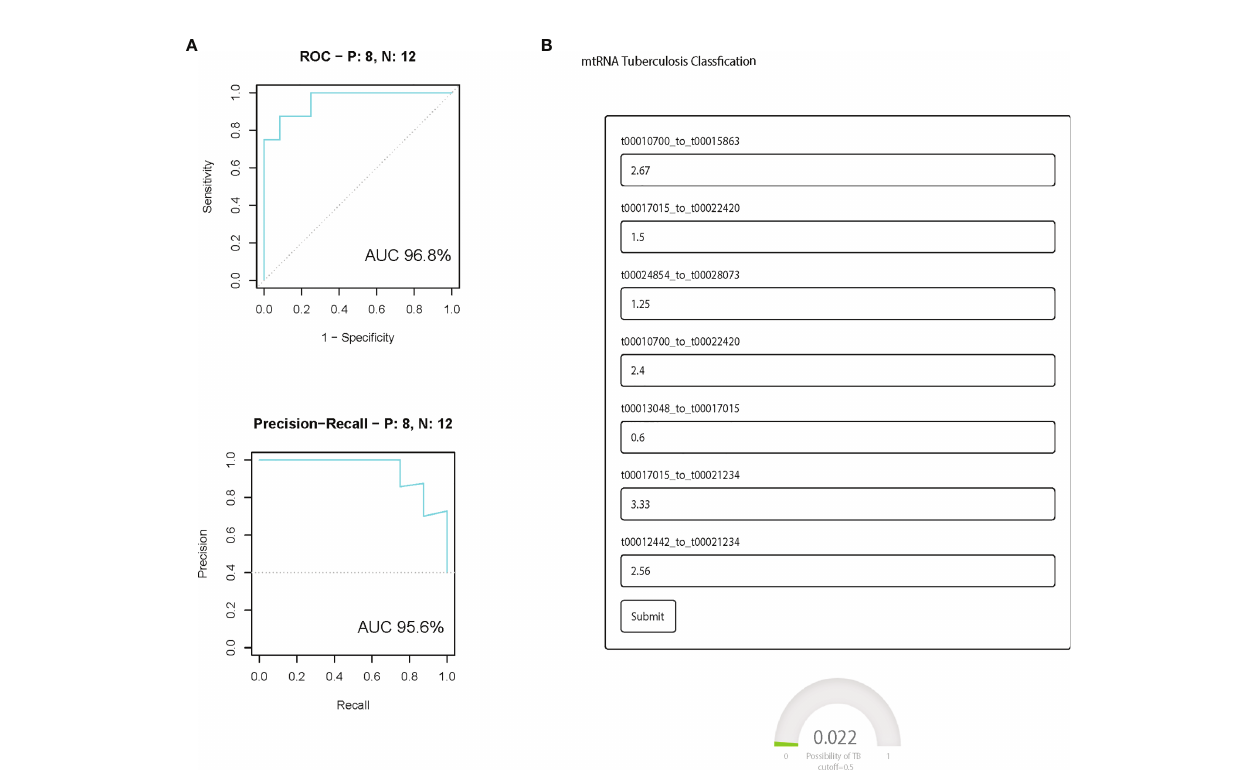
FIGURE 3 | The performance of the prediction model in the independent validation cohort. (A) ROC curve and PR curve of the diagnostic prediction model with mtRNA markers in the independent validation data set; All box plots are statistical signi fi cant, p <0.01. (B) Screenshot of the mtTB diagnosis